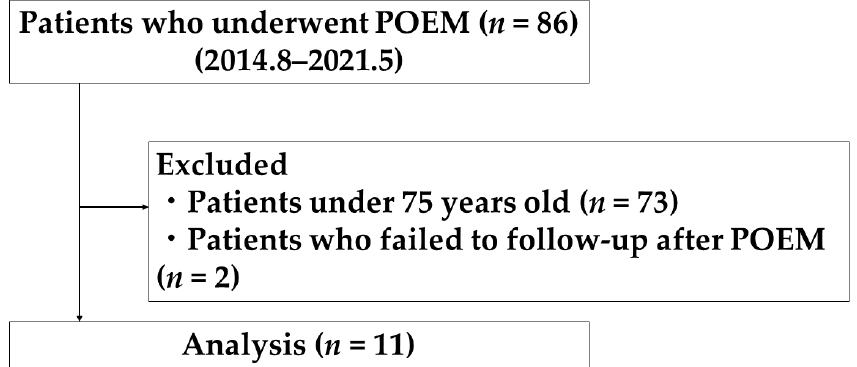
Figure 1. Flow diagram of patient enrollment. Table 1. Patient characteristics.